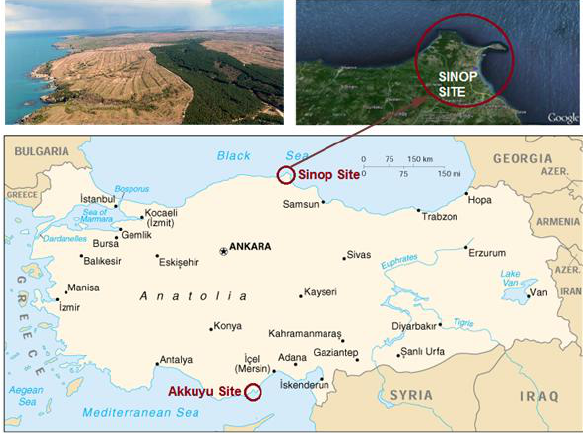
Figure 2. The map and images of the Sinop nuclear power plant. The area of 10.1 square kilometres allocated for the nuclear power plant is close to nature protection zones; i.e. adjacent to Bozburun Wildlife Development Area; 3.1 km from Hamsilos Nature Park that is the only fjord of the Black Sea, 4.9 km from Aksaz-Karagöl Wetland and 4.2 km from Sarıkum Nature Reserve (Figure 3). Since the agreement was signed, more than 650 thousand trees in the site area have been cut (i.e. almost 20%